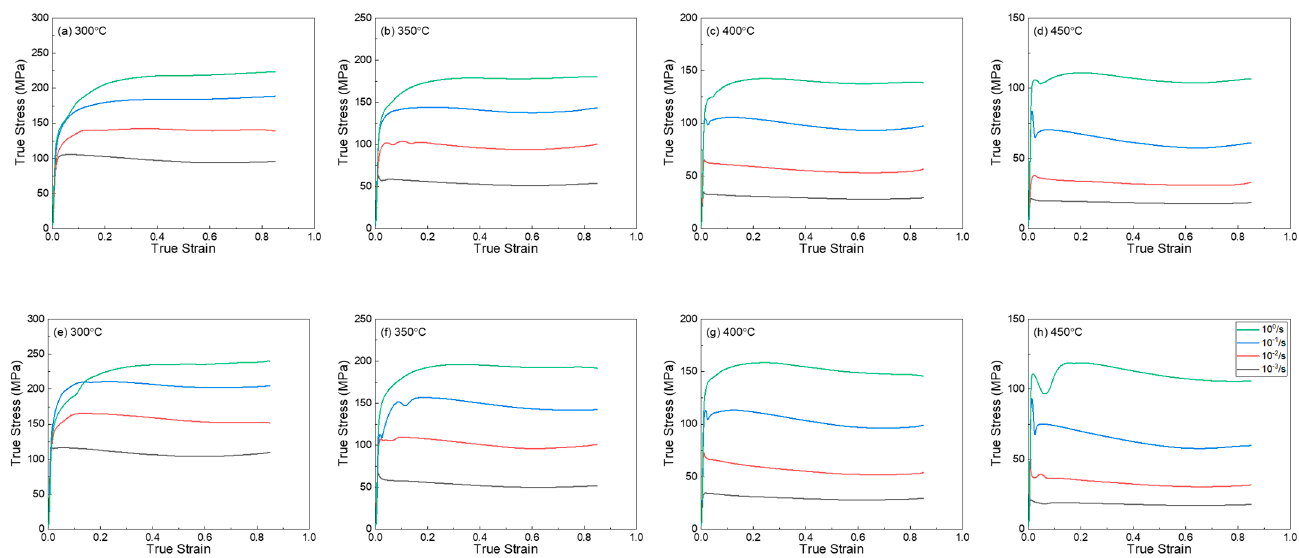
Figure 1. Flow curves of ( a – d ) Al-6Mg and ( e – h ) Al-8Mg obtained various temperatures and strain rates.